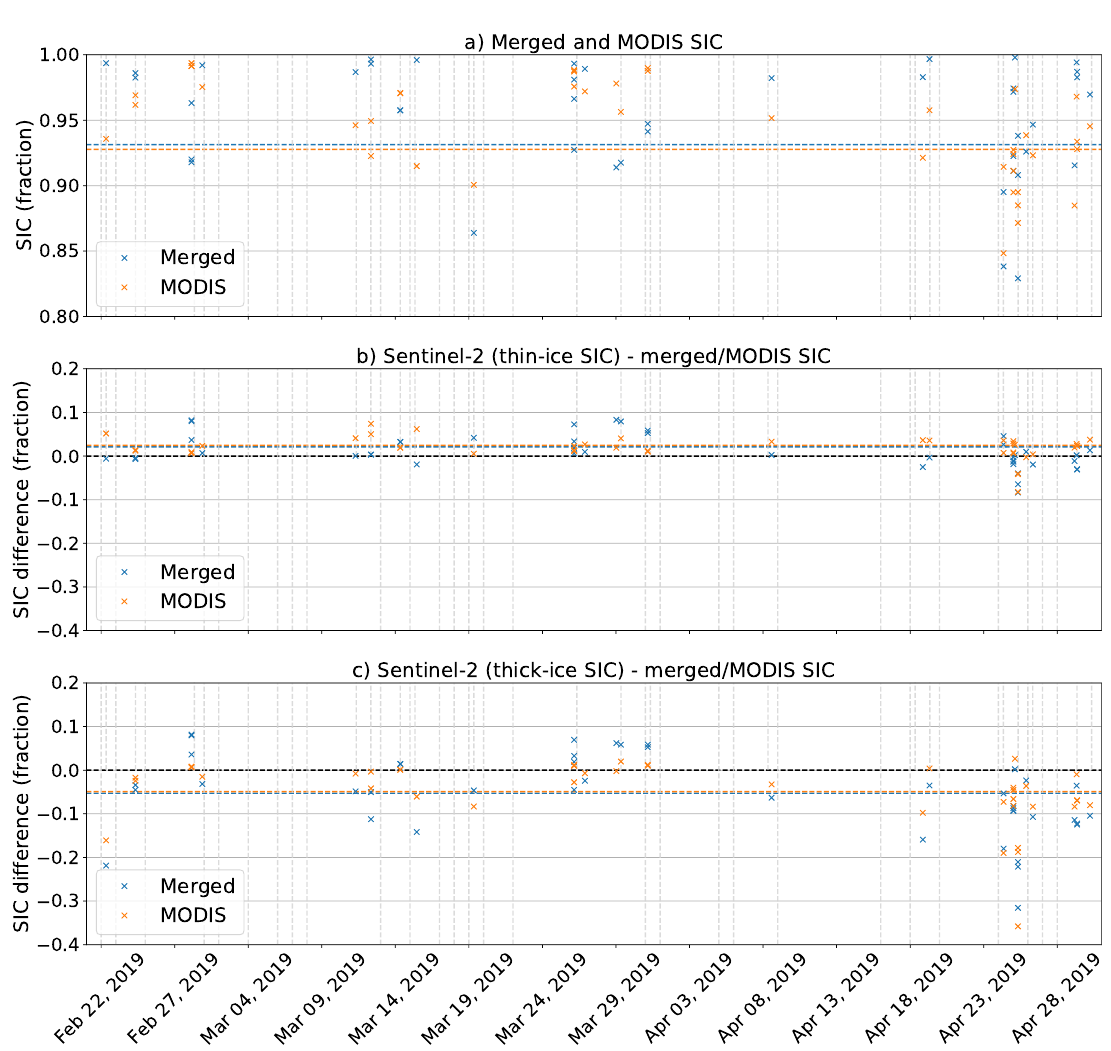
Figure 8. ( a ) Time-series of the merged and MODIS SIC corresponding to the Sentinel-2 time-series from Figure 7. The horizontal dashed lines show the mean of the respective dataset. ( b ) Difference between the merged and MODIS SIC and the thin-ice Sentinel-2 SIC from Figure 7. Positive differences mean that the Sentinel-2 SIC is higher. The horizontal dashed lines show the mean difference for the respective dataset. ( c ) Same as panel ( b ), but for the thick-ice Sentinel-2 SIC. The x-axis shows the date, the vertical lines mark the days with Sentinel-2